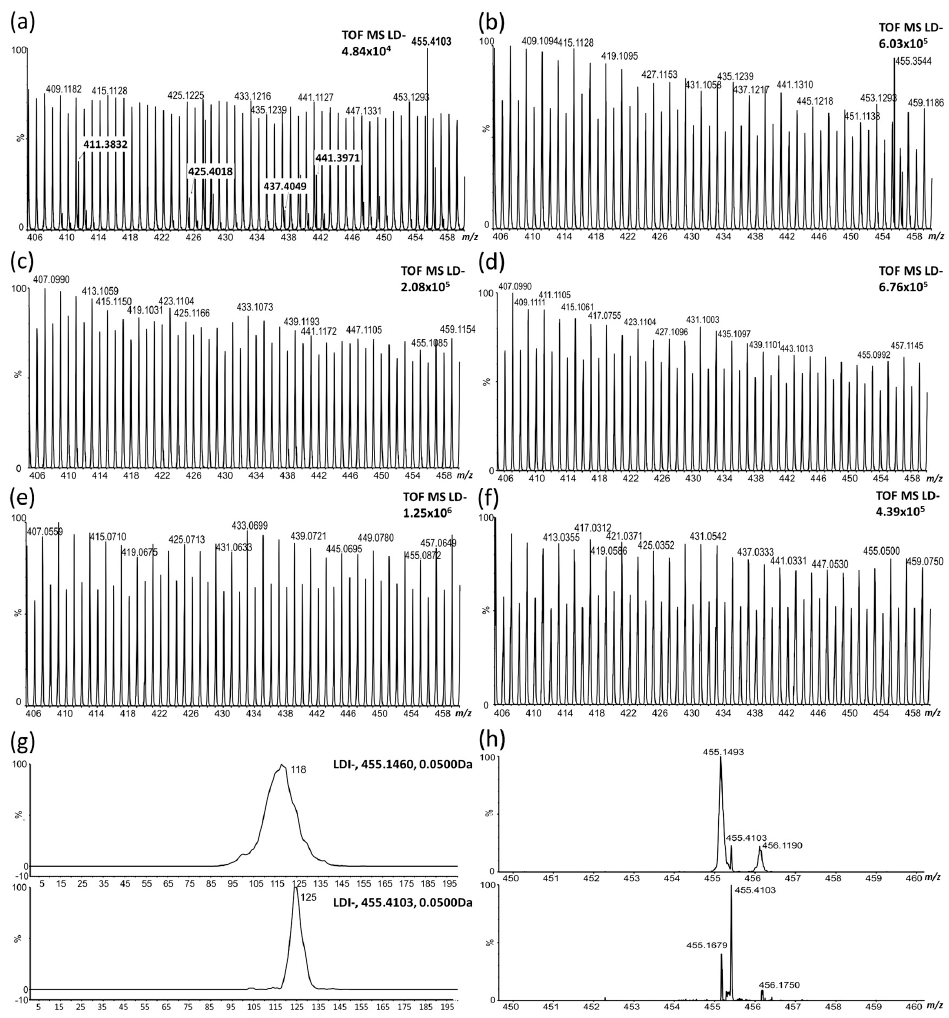
Figure 3. LDI-MS spectra in negative ionization mode. ( a ) external seed coat surface of JI64 genotype; ( b ) external seed coat surface of JI92; ( c ) internal surface of JI 64; ( d ) internal surface of JI92; ( e ) seed coat cross section of JI64 (MSI); ( f ) seed coat cross section of JI92 (MSI); ( g ) upper mobilogram (record of ion mobility scan) reconstructed at m / z 455.1460 and bottom mobilogram at m / z 455.4103; ( h ) upper MS/MS spectrum averaged over the whole mobility range and bottom MS/MS spectrum averaged over the second mobility peak (with maximum at 125 bins).